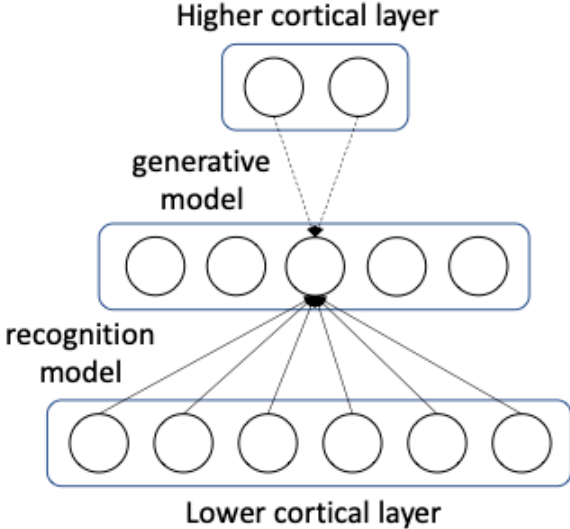
Figure 2. Every neuron—here only illustrated by the one central neuron—is bidirectionally connected to some or all the neurons in the higher and lower cortical layer. The generative and recognition models are indicated for a single neuron.